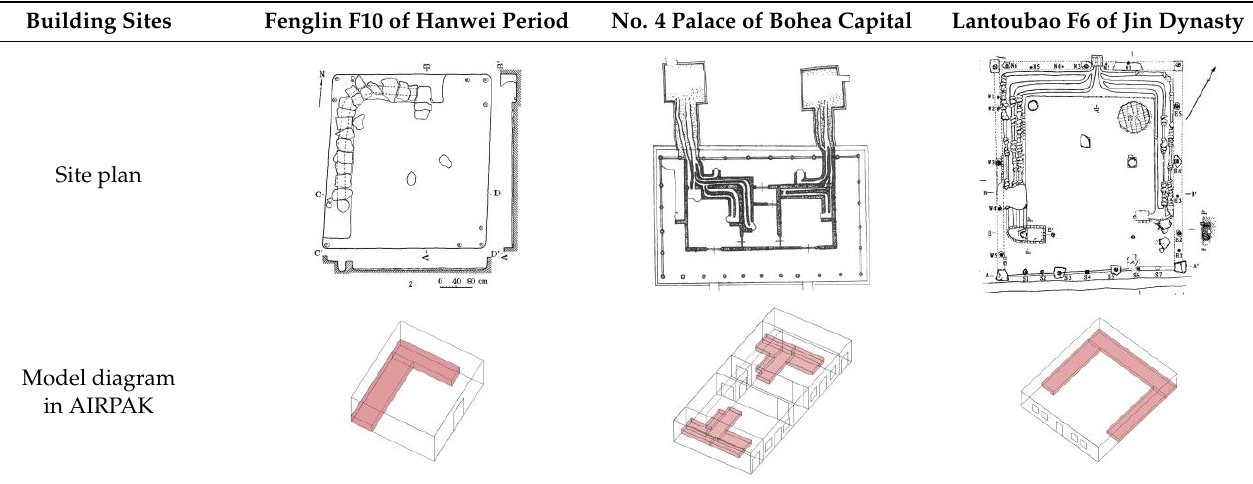
Table 7. Case site plan and model diagram [18–20].